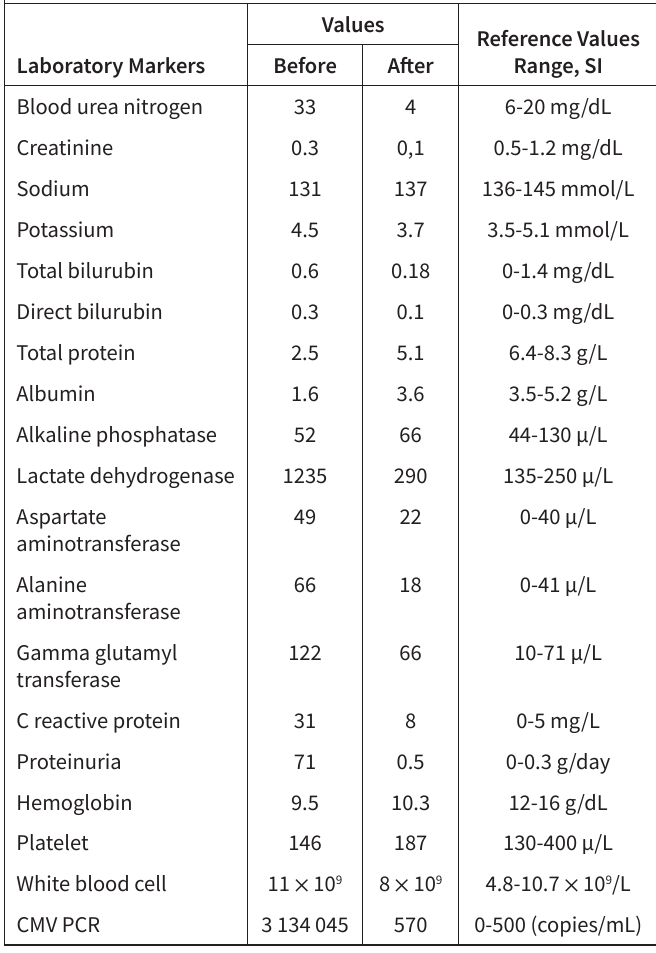
Table 1. Biochemical Parameters of the Patient Before and After Treatment (After 6